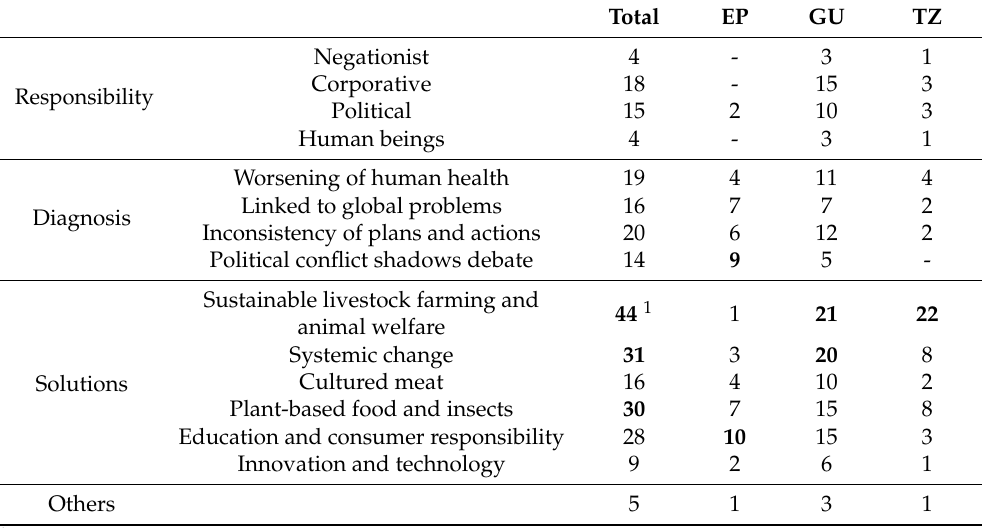
Table 4. Distribution of frames by newspaper according to the proposed categories (raw